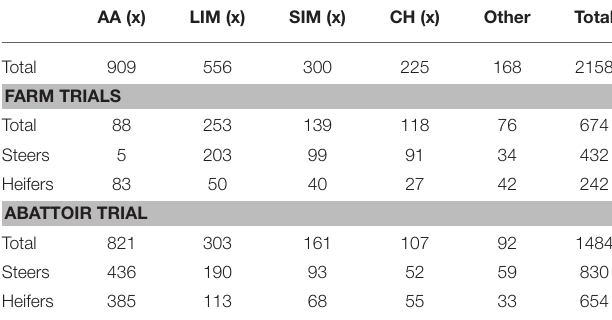
TABLE 1 | Summary of cattle used in the development of liveweight prediction